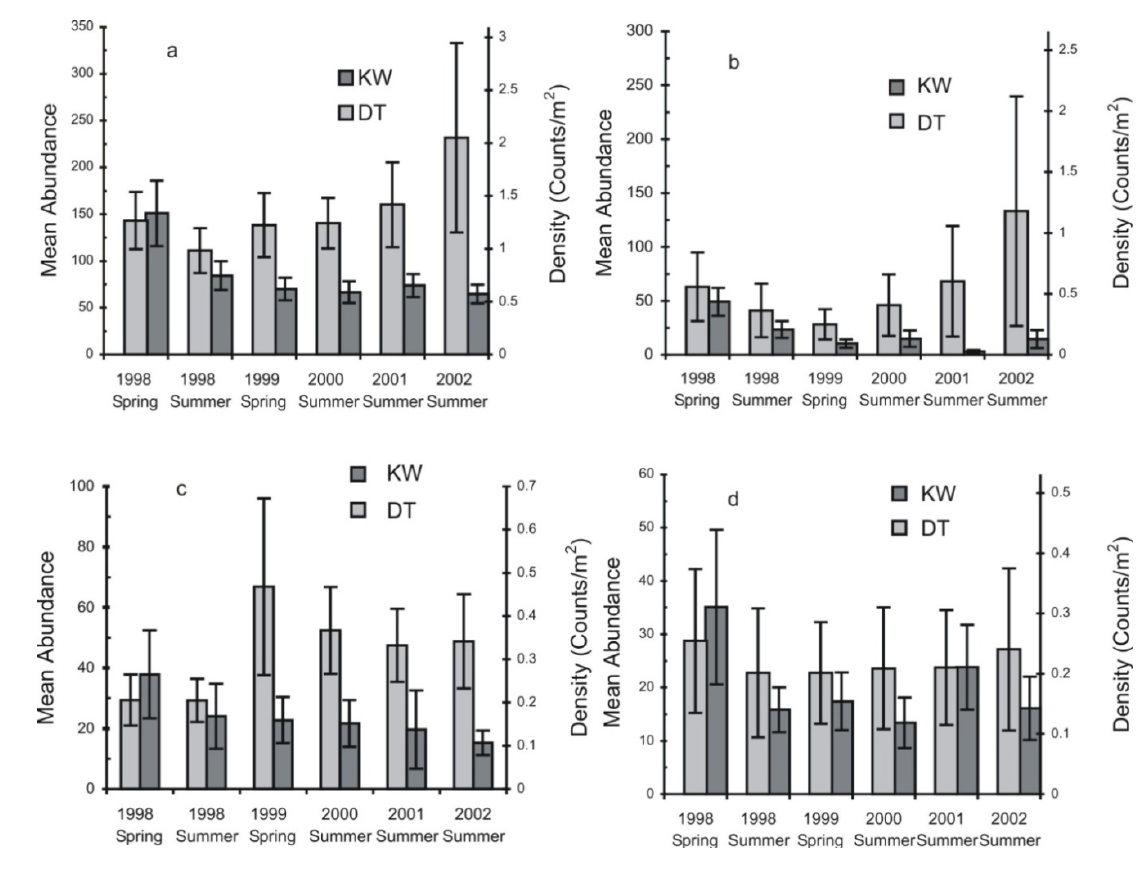
Figure 2. Mean coral abundance as total colony count and density (count/m 2 ) of Dry Tortugas (DT) and Key West (KW) reef areas for 1998 to 2002 survey periods for: ( a ) all colonies; ( b ) acroporids; ( c ) Gorgonia spp; and ( d ) massive species ( Colpophyllia natans , Montastraea annularis complex and Montastraea cavernosa ).